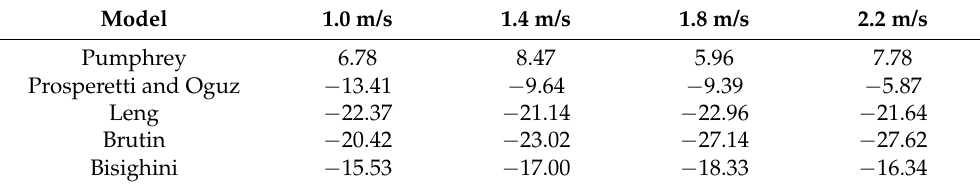
Table 5. Deviation between the maximum dimensionless crater depths predicted from the literature models and the maximum values of the quantity calculated from the simulations at the different